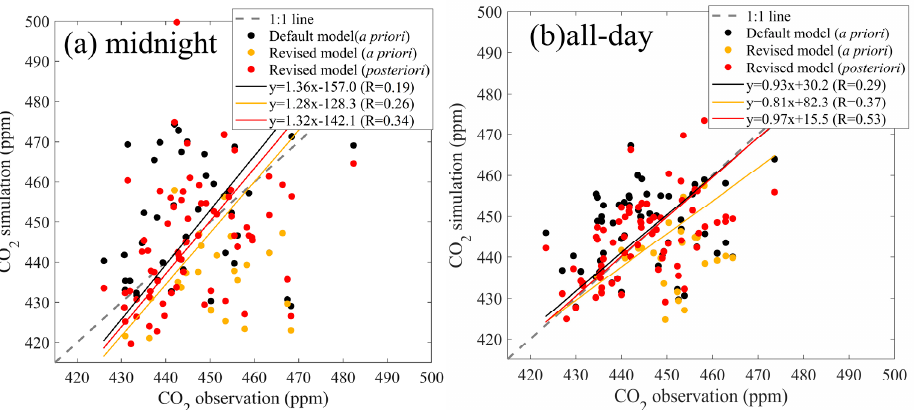
Figure 8. Scatter plots of ( a ) midnight and ( b ) daily CO 2 average between observations and simula- tions, note simulations from the default model (using a priori emissions), revised model (using a priori emissions), and revised model (using posteriori emissions) are compared.